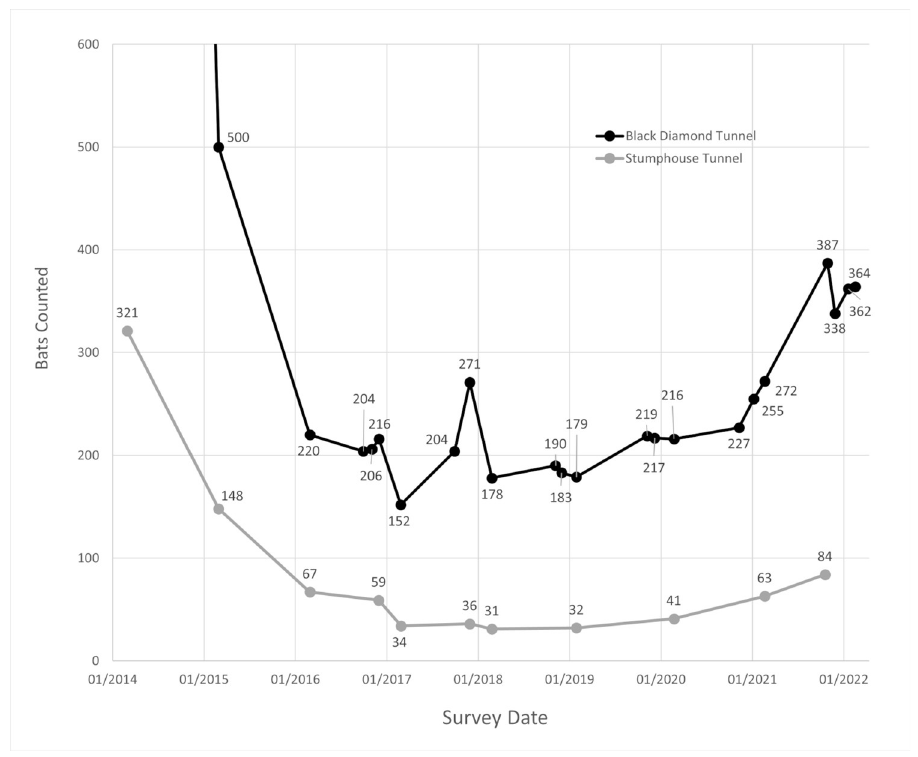
Fig 4. Comparison of bat population censuses at Black Diamond Tunnel and Stumphouse